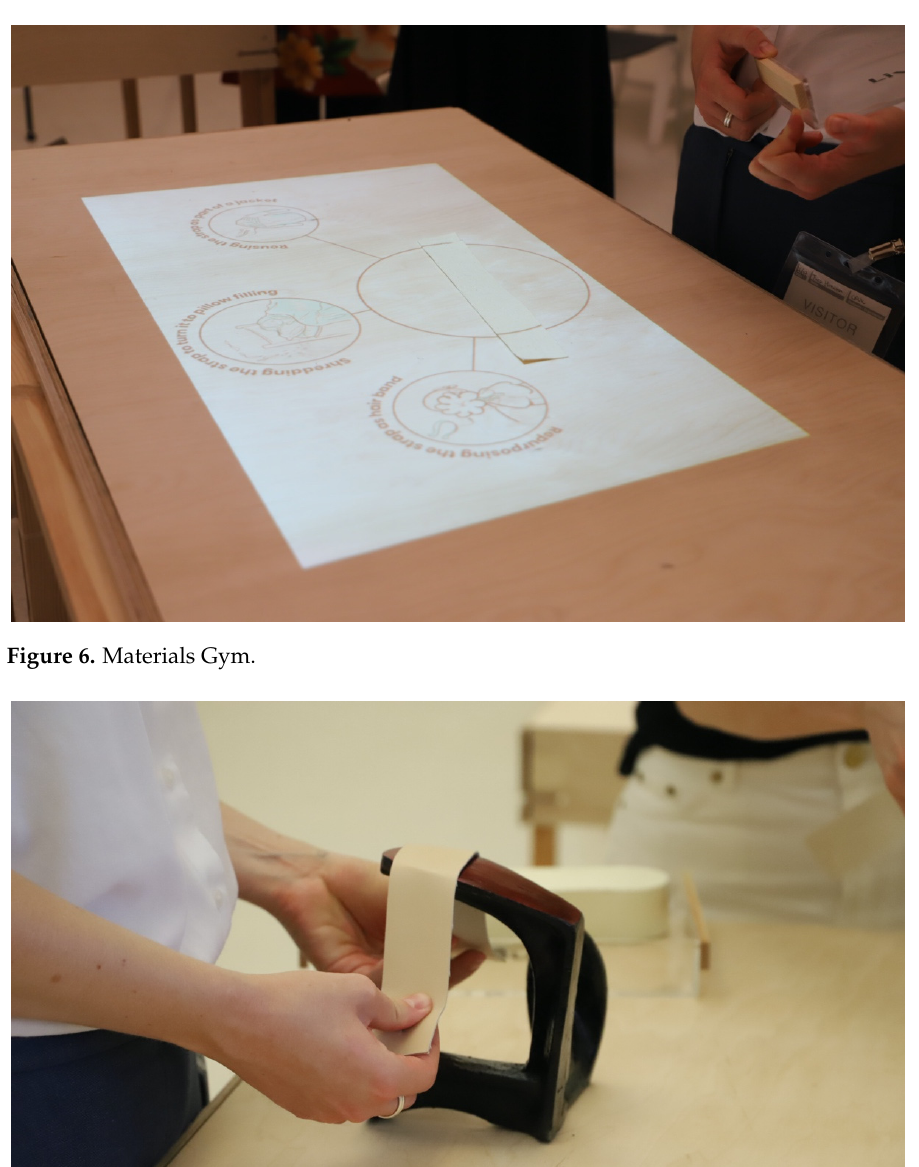
Figure 5. Material Stories.